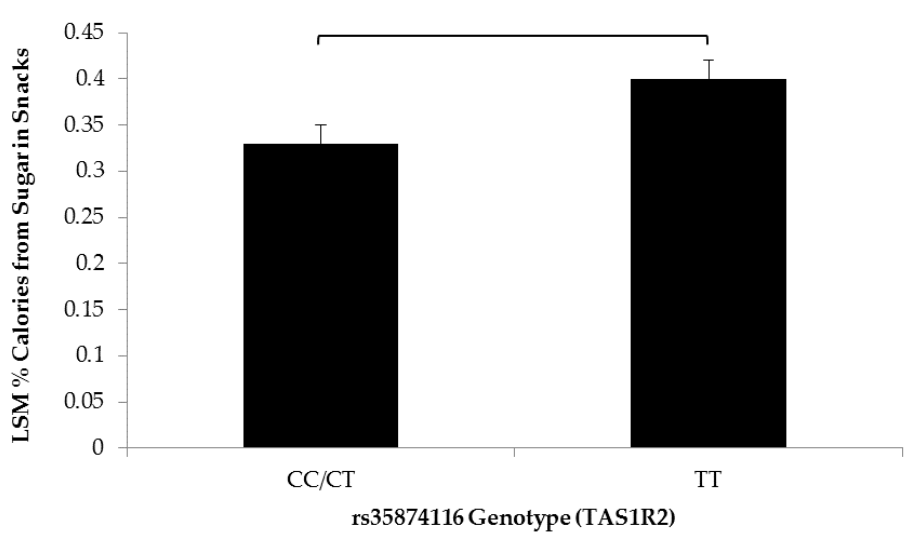
Figure 2. Least squares means of the percent calories from sugar in snacks by rs35874116 genotype Statistical differences between the relative calories from sugar in snacks for rs35874116 of the TAS1R2 sweet taste receptor gene were determined using generalized estimating equations ( n = 47; * p = 0.008) and a dominant genetic model [20]. Children carrying the TT genotype ( n = 25), predicted to prefer sweet, consumed snacks with significantly more calories from sugar than carriers of the C allele ( n = 22). Values are reported as least squares means + SE. *